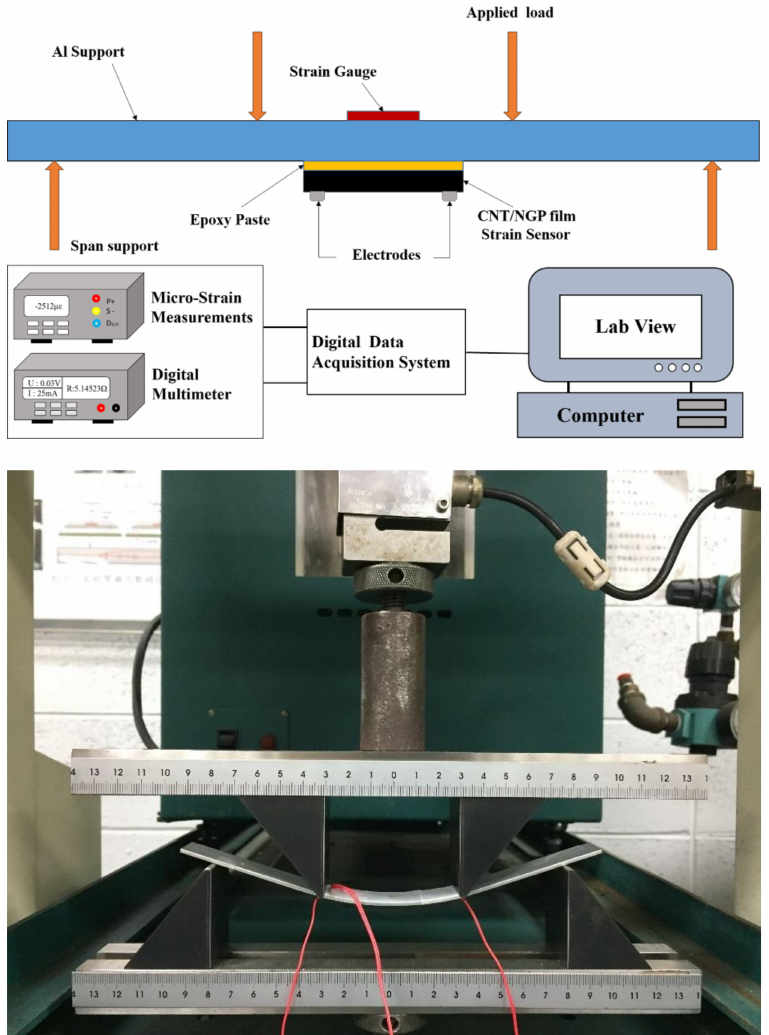
Figure 6. Schematic diagram and experimental setup of the four-point-bending